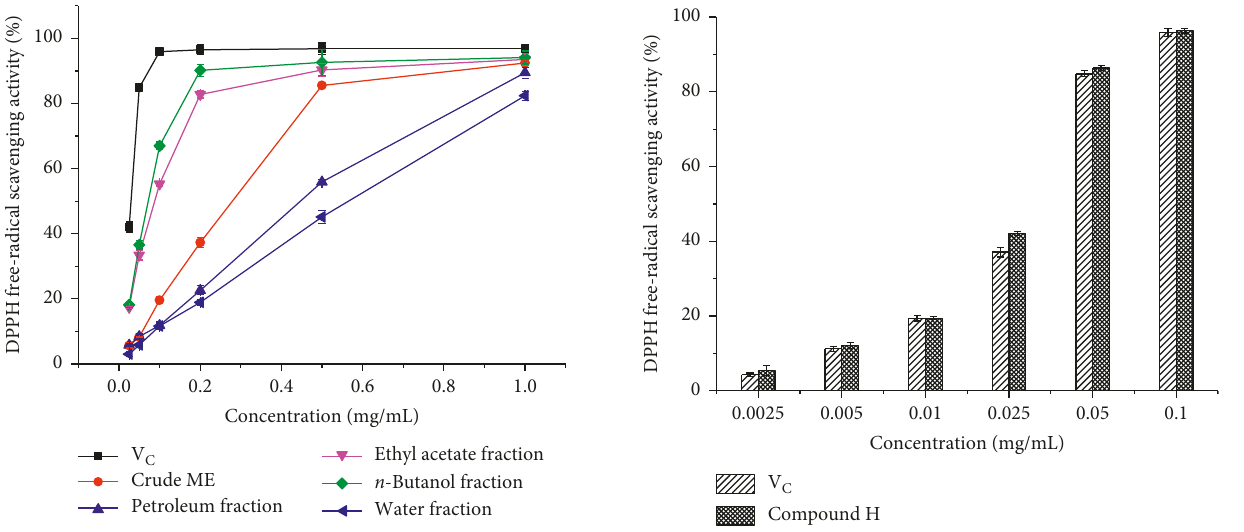
Figure 4: DPPH-scavenging activity of compound H and V C , and organic